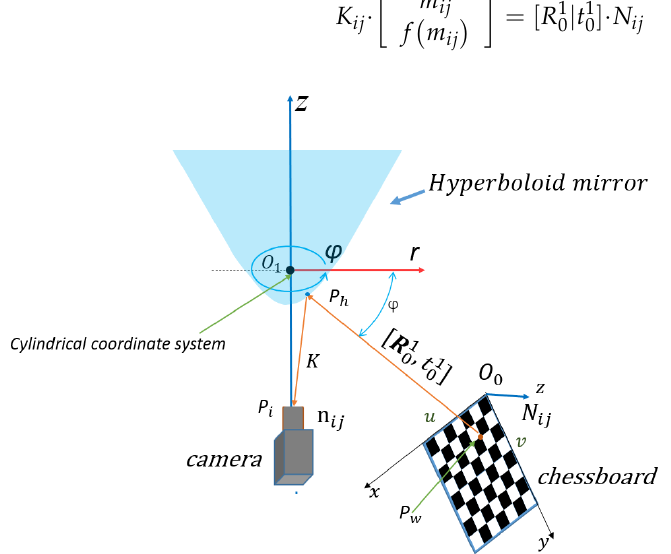
Figure 11. Calibration principle of panoramic vision systems for hyperboloid reflector.